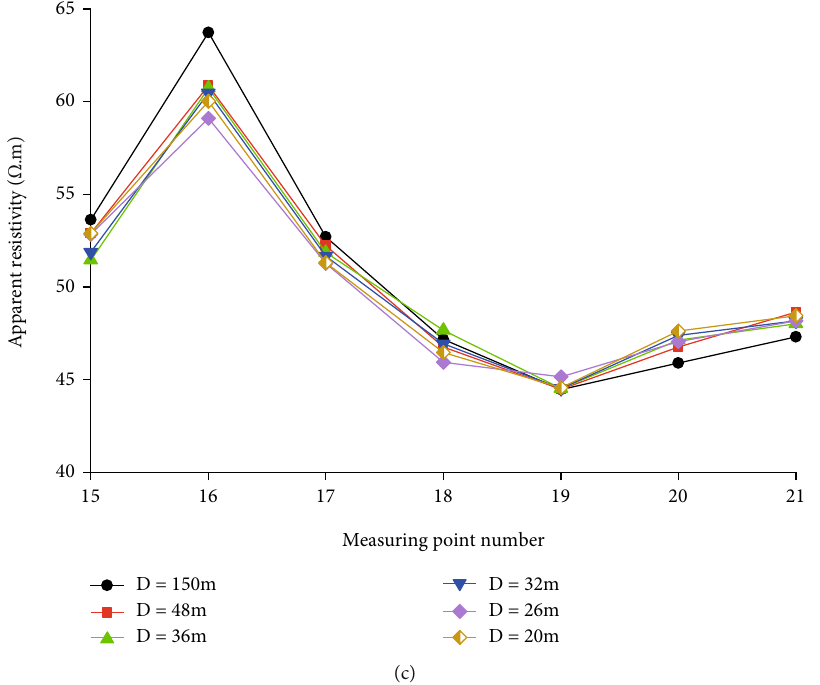
Figure 18: Characteristics of apparent resistivity along the cable. (a) Condition of one electrode distance. (b) Condition of two times the electrode distance. (c) Condition of three times the electrode distance.